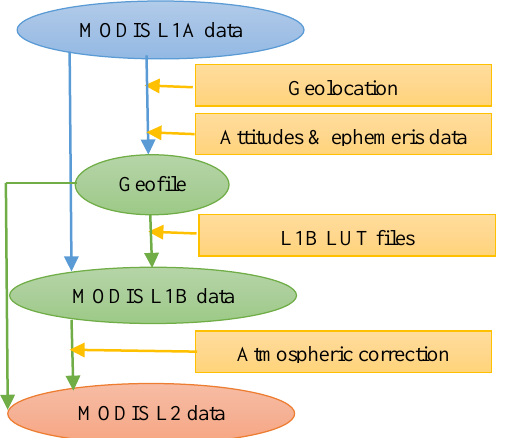
Figure 2. The flow chart of data processing by SeaDAS